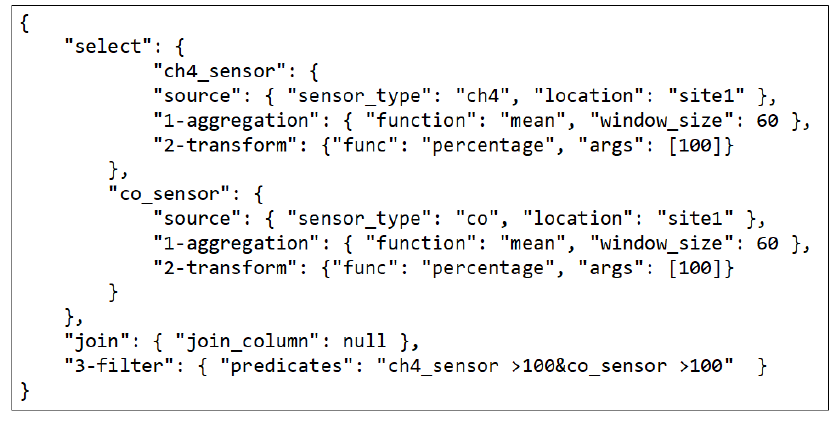
Figure 5. An example query.